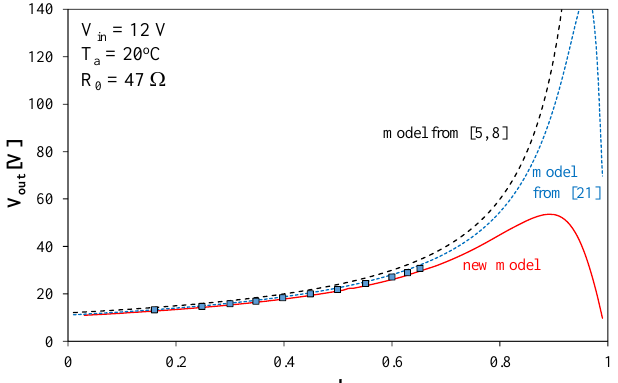
Figure 11. Computed and measured dependence of internal temperature of the diode on load